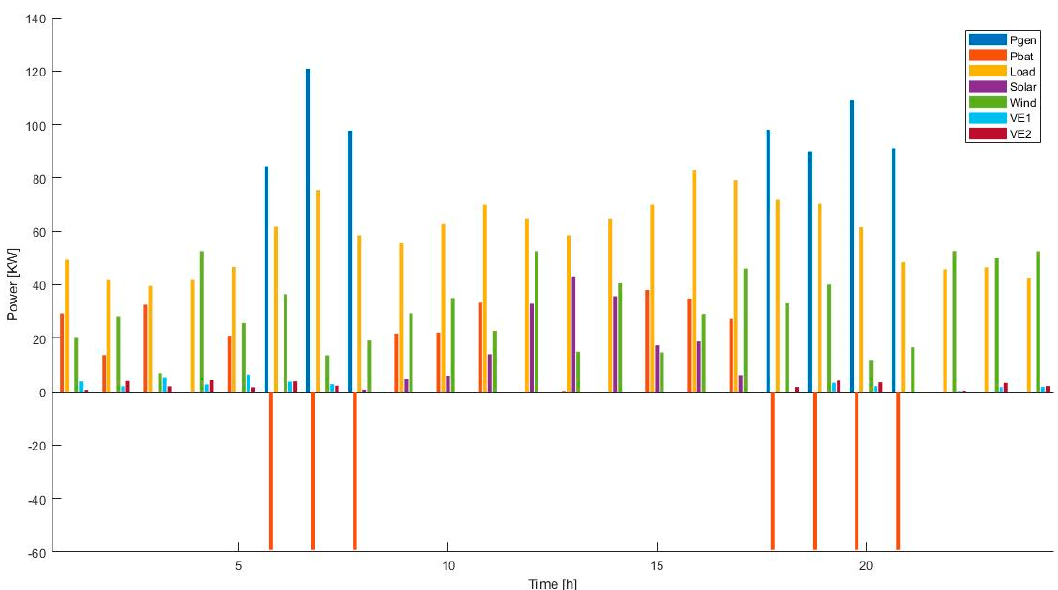
Figure 15. Availability and dispatch of the MG with the storage system after the 60% of its useful life.